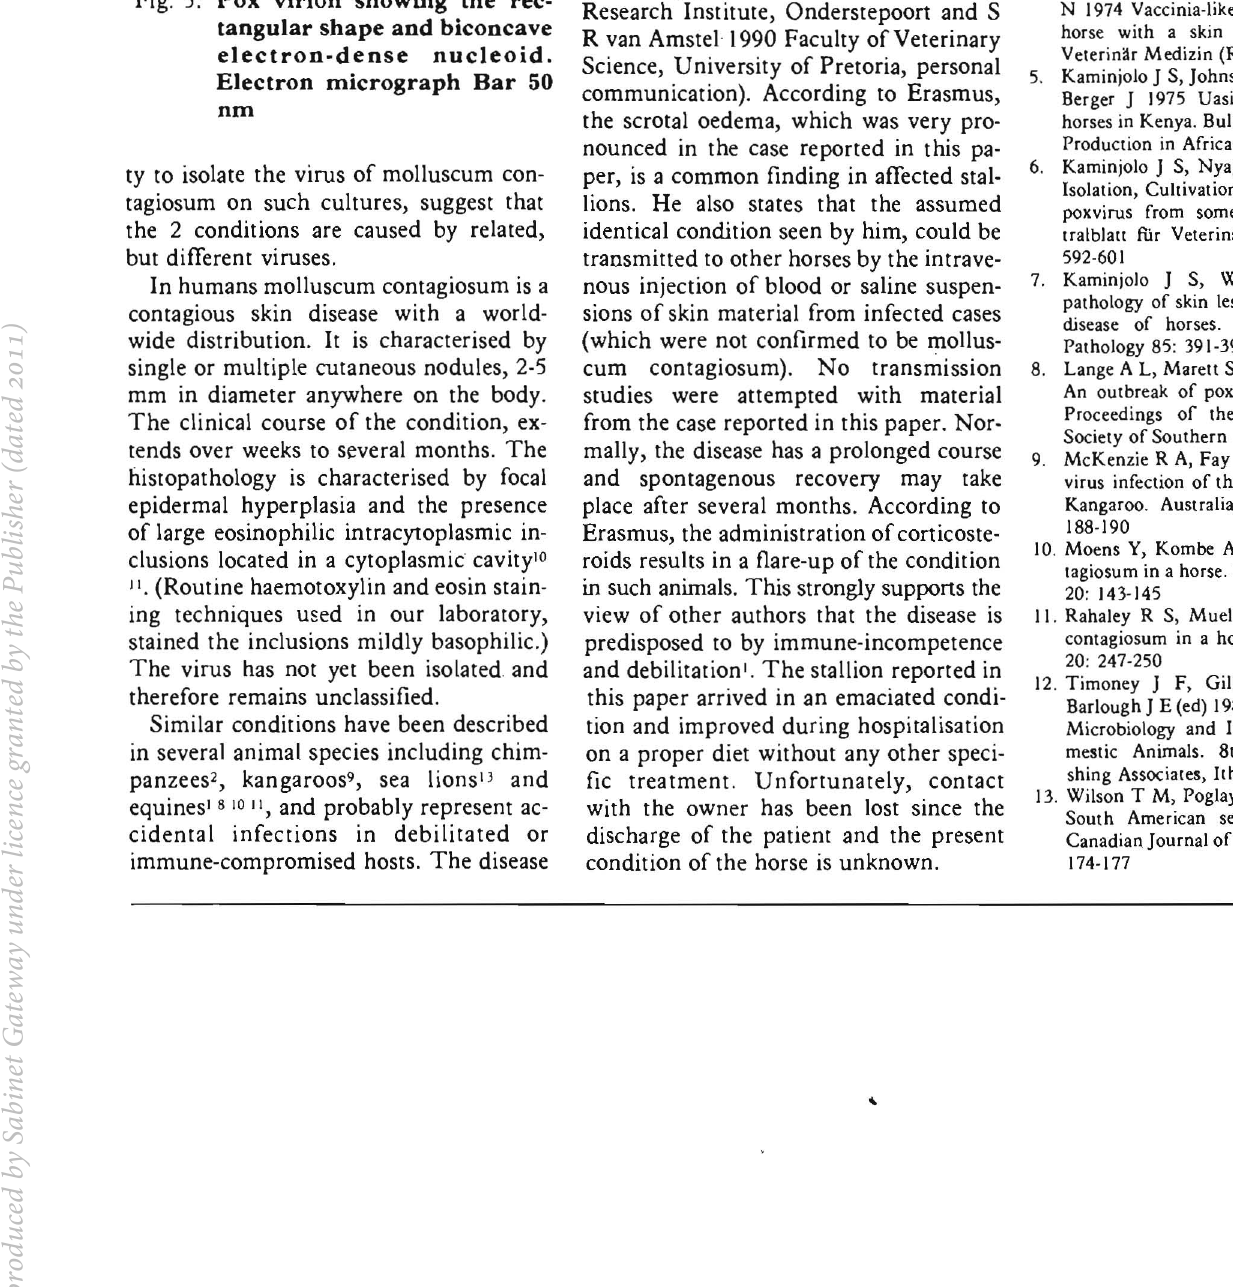
Fig. 5: Pox virion showing the rec tangular shape and biconcave electron-dense